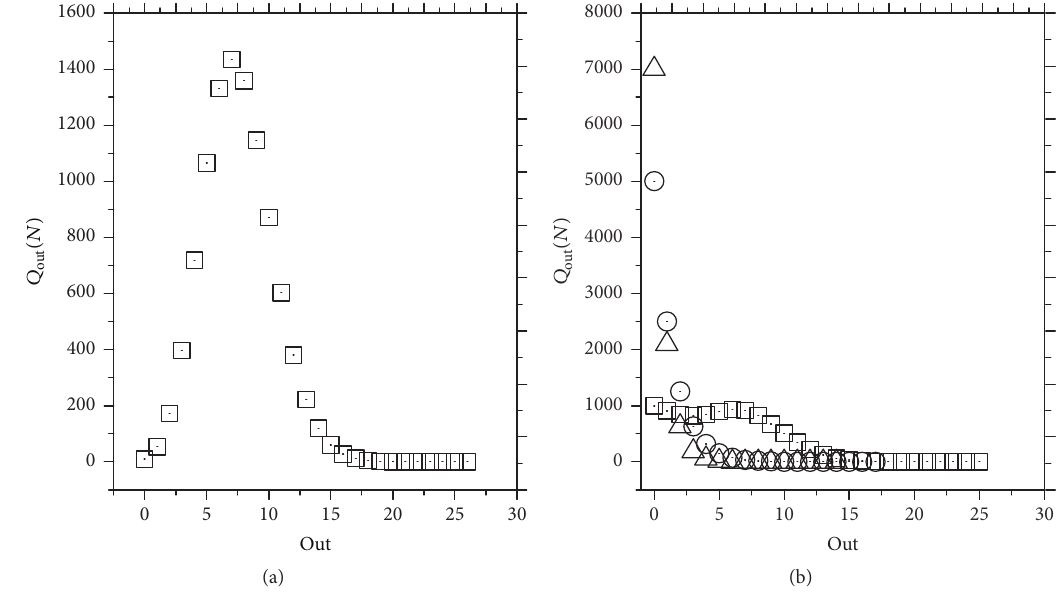
Figure 5: Out-degree distribution ( 𝑄 out ) obtained numerically with (a) 𝜙 = 1/𝑁 and (b) 𝜙 = 𝑝 taking values 𝑝 = 0.1 ( ⊡ ), 𝑝 = 0.5 ( ⊙ ), and 𝑝 = 0.7 ( Δ ) as a function of the out-degree (out).